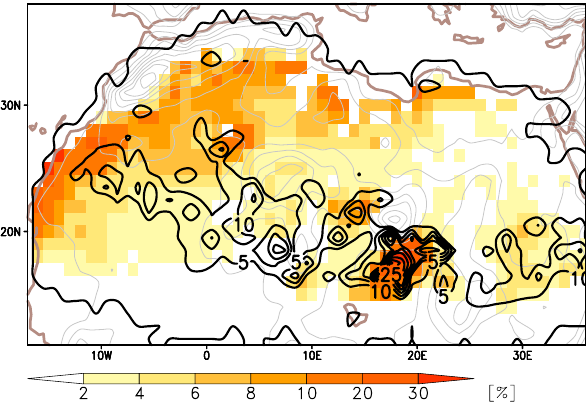
Figure 8. Time series of total dust emissions. Shown are dust emis- sion per year as total amounts for (black) all processes (lines) in all seasons and (crosses) in spring for 1989–2008. Red shows emission totals associated with atmospheric depressions and blue emission totals associated with long-lived and migrating cyclones. All values are integrated over the entire of North